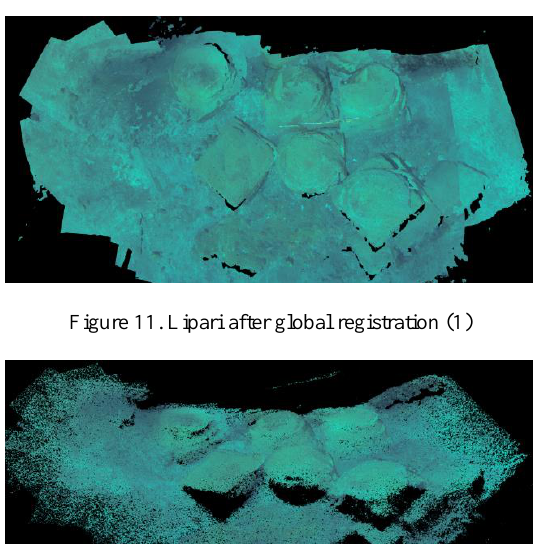
Figure 10. Lipari particular RGB-D (2)